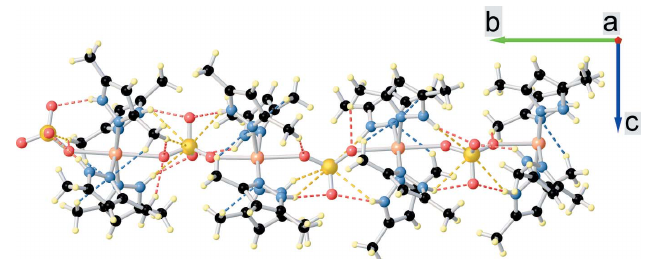
Figure 4 Intramolecular hydrogen-bond network in the asymmetric unit of the title compound. Hydrogen bonds with the participation of oxygen atoms are indicated in red, blue for nitrogen atoms and yellow for sulfur atoms. Hydrogen donors are carbon atoms of methyl groups and nitrogen atoms of NH groups, while hydrogen acceptors are sulfur and oxygen atoms, and pyridine-like nitrogen atoms of the pyrazole ring.